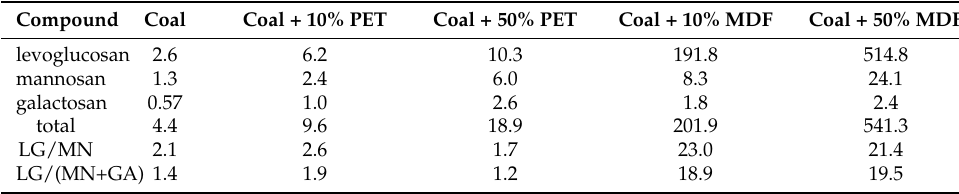
Table 6. Biomass burning markers emission factors (mg/h).